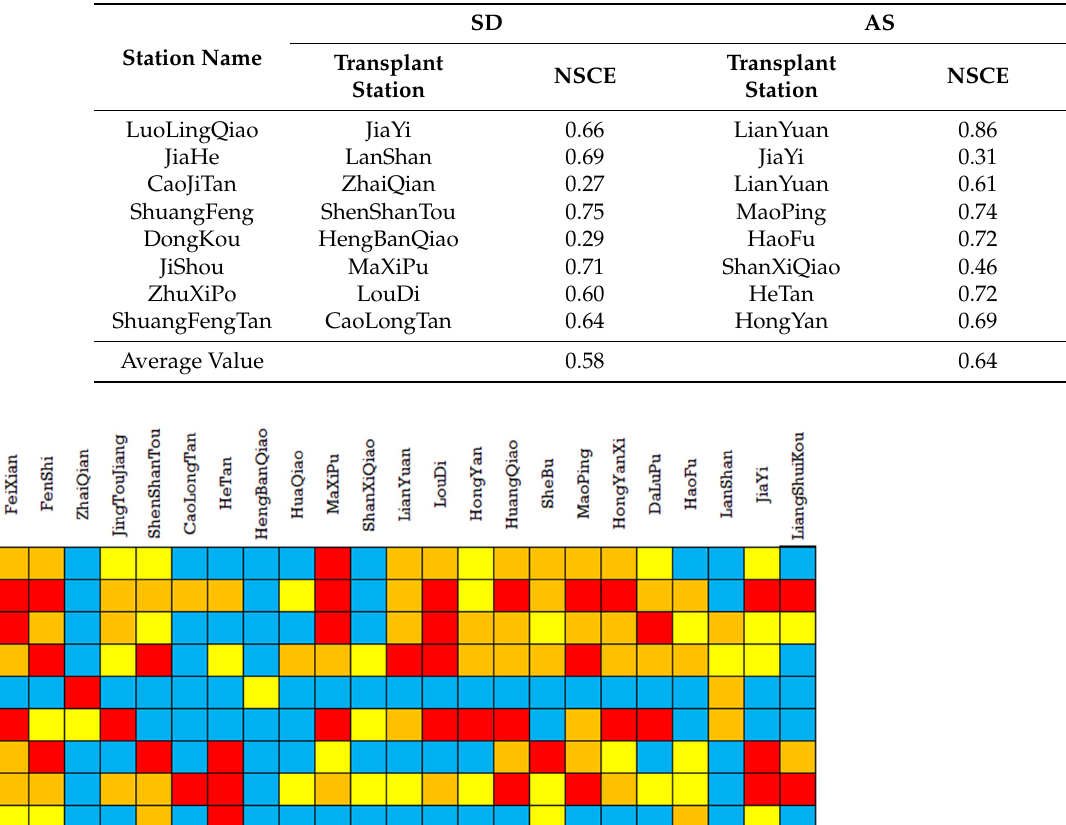
Table 6. Transplant results of SD and AS methods.